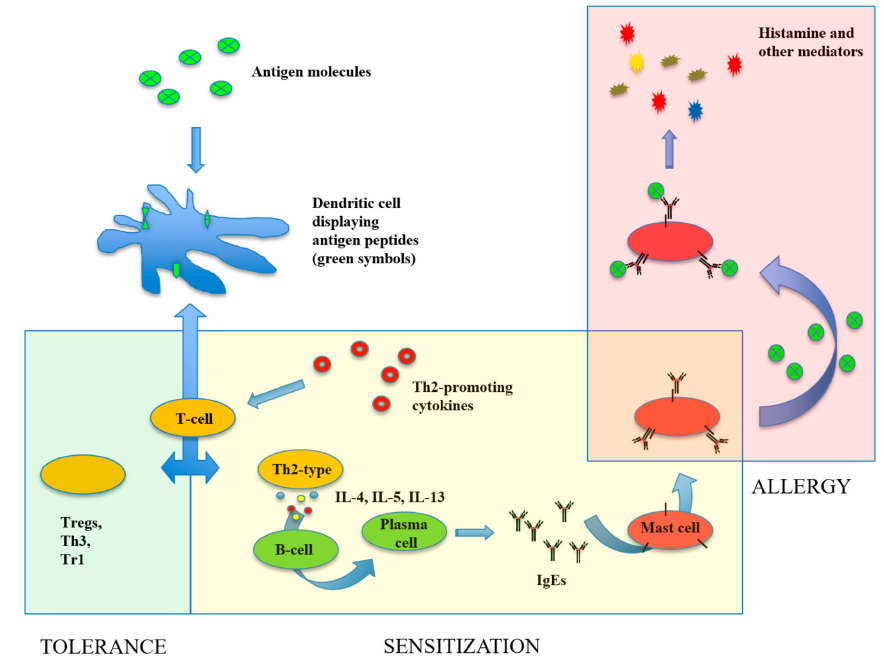
Figure 1. The onset of food allergy reactions. In the gastrointestinal tract, the food antigenic proteins are captured by dendritic cells (DCs) and hydrolysed into small peptides, which are displayed on the cell surface associated with the molecules of the major histocompatibility complex. After migration to the mesenteric lymph nodes, DCs interact with T cells to initiate the adaptive immune response. In the absence of particular stimulatory signals, T cells di ff erentiate into suppressive T cells (Treg, Th3, Tr1) originating a tolerance status (green area). It may happen, however, that in the presence of Th2-promoting cytokines (occurring in the gastrointestinal tract, in the skin and respiratory tract, especially in the presence of epithelial injuries) T cells become Th2-type helper T cells. The Th2-type cells migrate to di ff erent tissues and produce specific cytokines (IL-4, IL-5, IL-13) that can induce di ff erentiation of food antigen-specific B cells into plasma cells producing antigen-specific IgE. In the so-called sensitization phase (yellow area), the produced IgE molecules bind to specific receptors on the tissue mast cell. From now on, a subsequent interaction of the antigen with its specific IgE bound to the mast cells will cause mast cell degranulation with release of molecules, such as histamine, prostaglandins, tryptase and cytokines, leading to allergic reaction (red area). More details on the pathogenesis of food allergy can be found in specific review articles